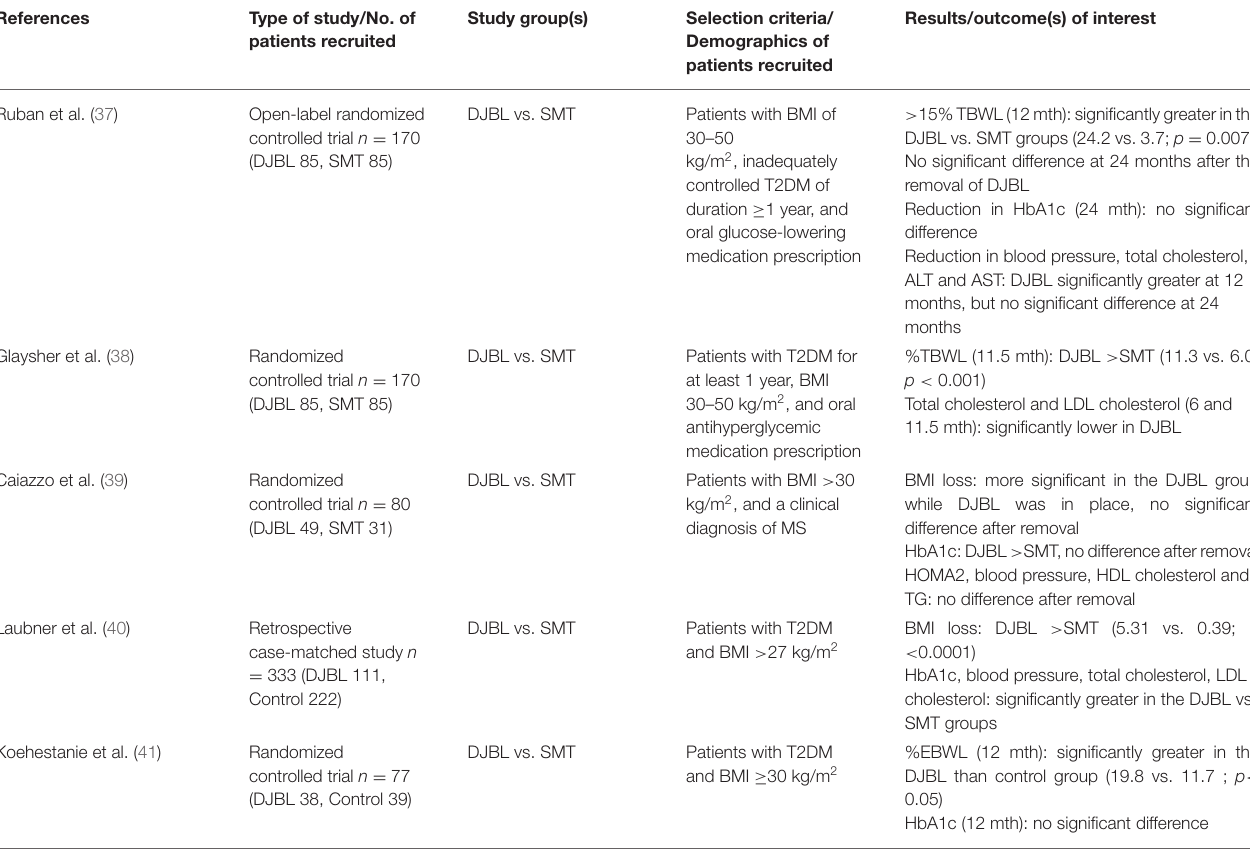
TABLE 5 | Studies included for the study of DJBL on Metabolic Syndrome and related comorbidities in